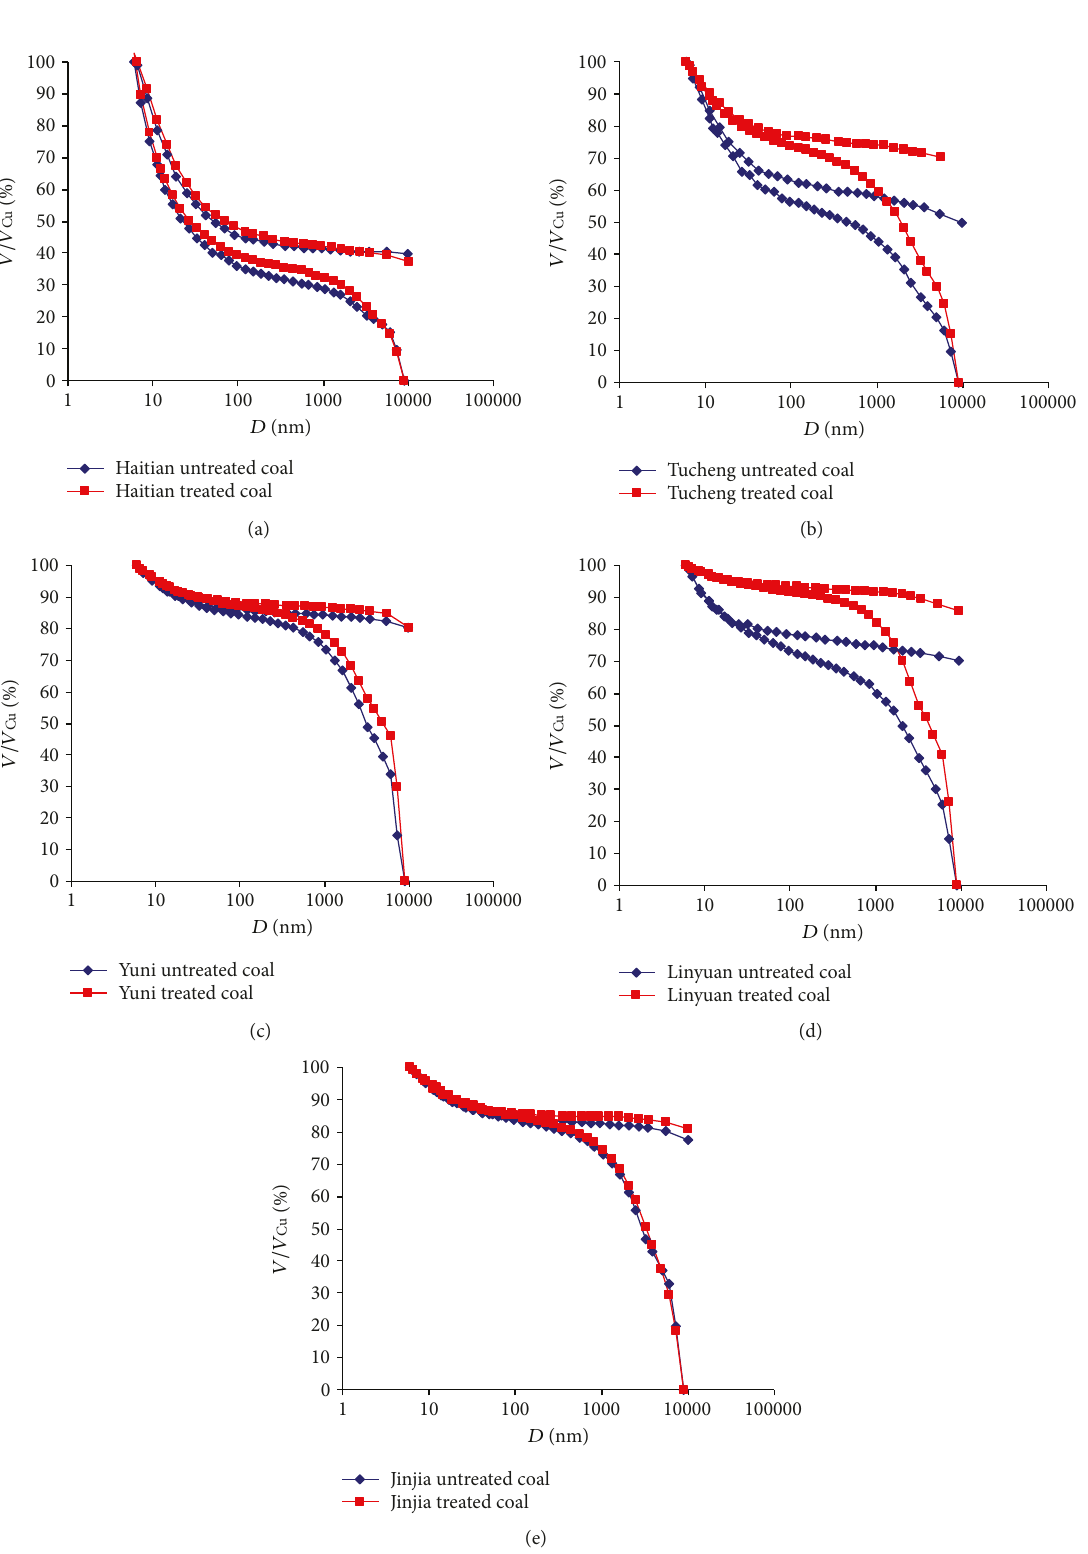
Figure 5: V / V Cu of the samples as a function of pore diameter: (a) Haitian samples, (b) Tucheng samples, (c) Yuni samples, (d) Linyuan samples, and (e) Jinjia